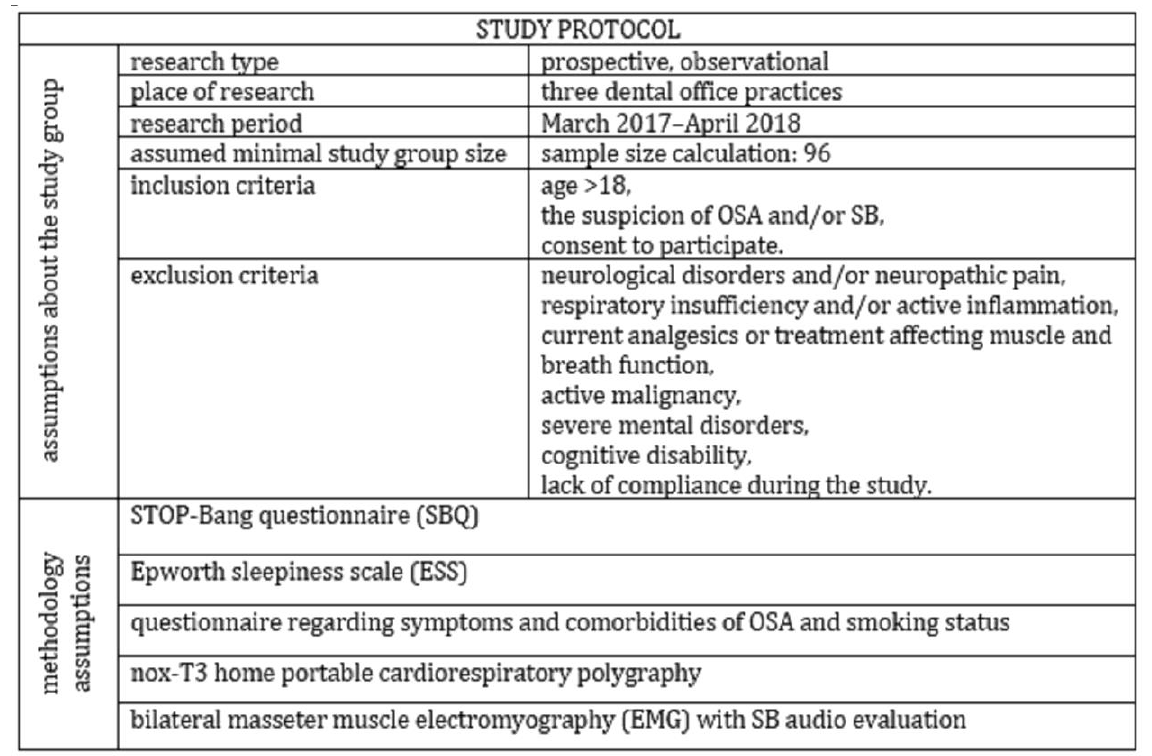
Figure 1. Flowchart of the study.